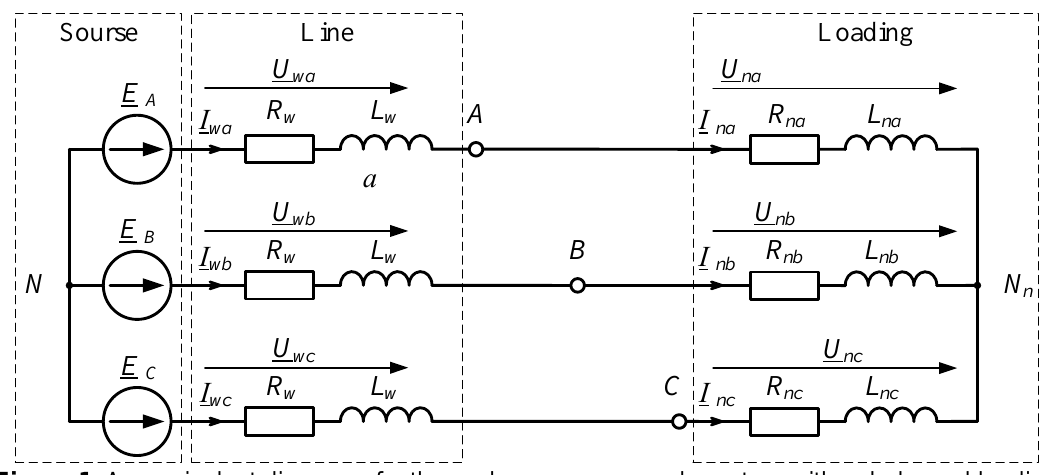
Figure 1. An equivalent diagram of a three-phase power supply system with unbalanced loading The three-phase source of electromotive force